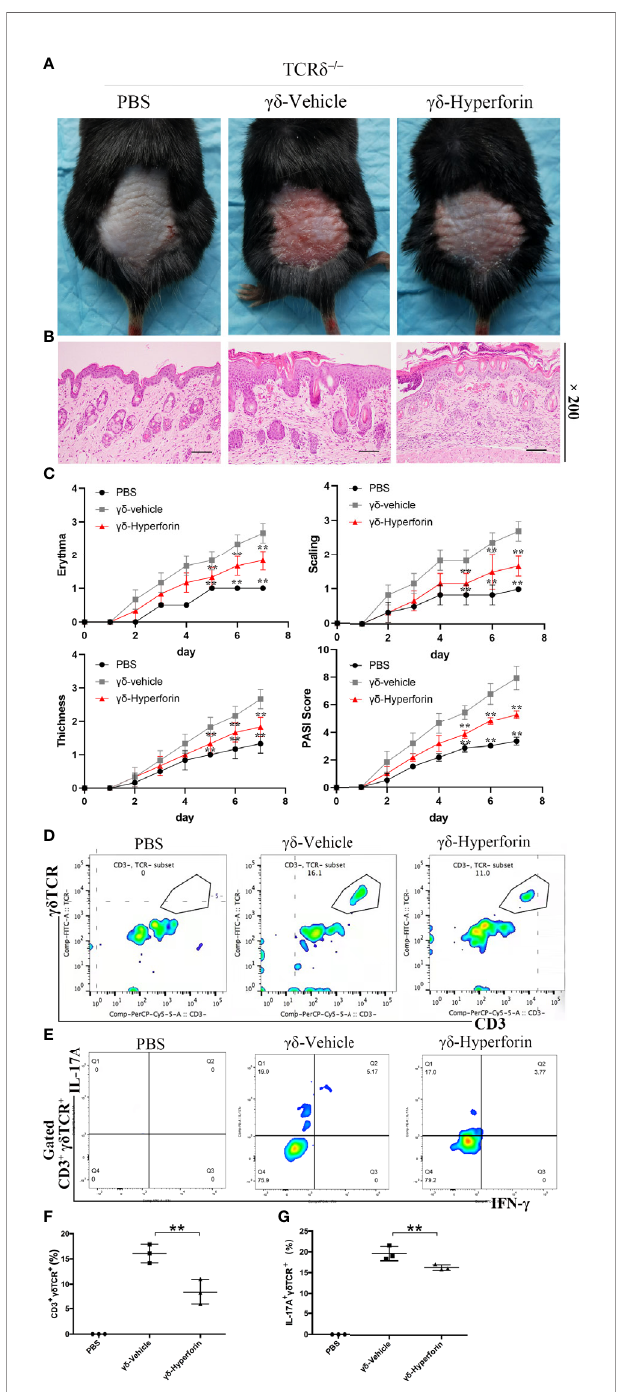
FIGURE 6 | Effects of hyperforin in gd T cells on IMQ-induced psoriasis-like skin in fl ammation. Tcrd – / – mice were transferred with PBS or naive gd T cells pretreated with hyperforin ( gd -Hyperforin) or not ( gd -Vehicle). The mice were then subjected to IMQ-induced psoriasis as part of the psoriasis-like mouse model. The back-skin photos of mice (A) and H&E staining of skin lesions (B) (scale bars: 100 m m), and PASI scores (C) . n = 3. (D, F) Detection of the transferred gd T cells in skin. (E, G) Percentage of IL-17A + cells in dermal gd T cells (gated on CD3 + gd TCR + T cells). n = 3. Data are presented as the mean ± SD. (**P < 0.01).